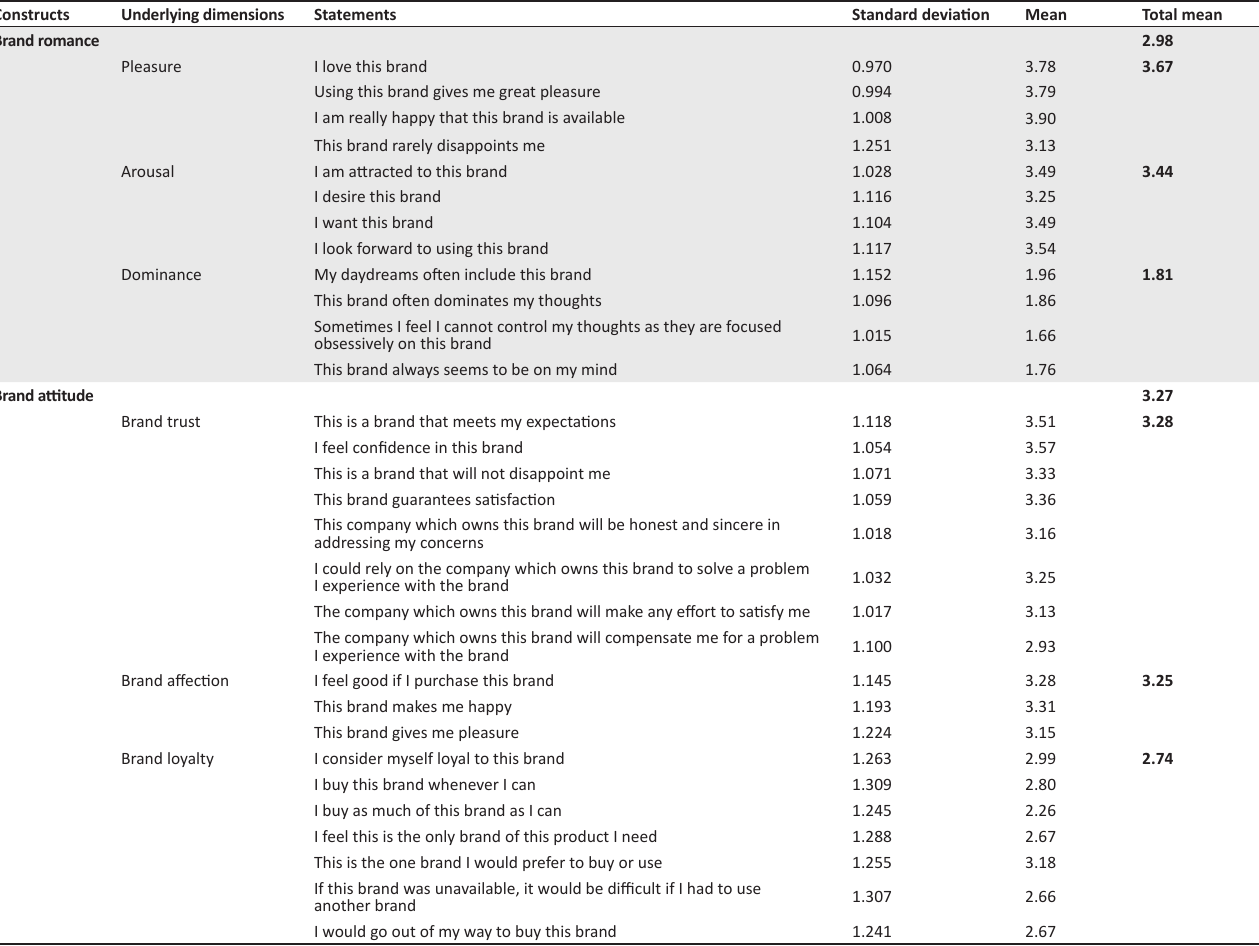
TABLE 3: Brand romance, brand attitude and brand loyalty of respondents toward their cellphone brands.